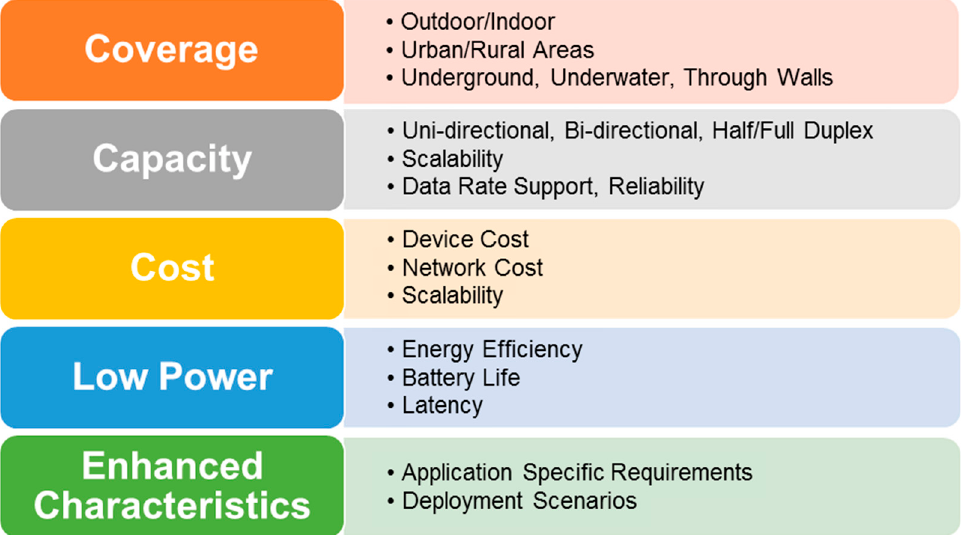
Figure 1. Application requirement attributes.